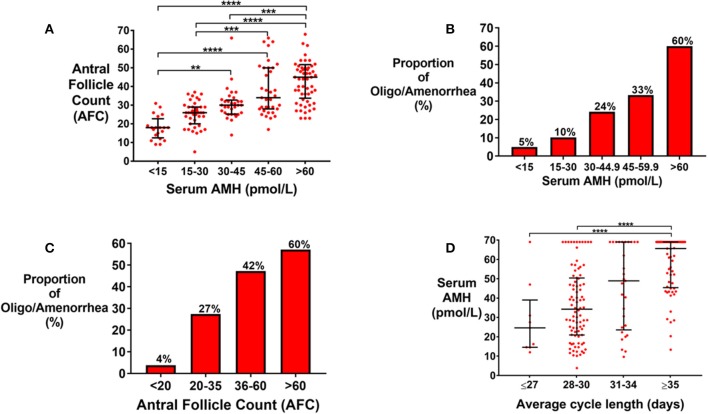
(A) Scattergram (median ± IQR) of serum anti-Mullerian hormone, AMH (pmol/L), by total antral follicle count (AFC) across both ovaries. Groups were compared by Kruskal Wallis test with post-hoc Dunn's multiple comparison test. AFC was significantly higher by category of serum AMH. **P < 0.01, ***P < 0.001, ****P < 0.0001. (B) Frequency of oligomenorrhea was increased by category of serum AMH (pmol/L) when compared by univariate logistic regression (P < 0.0001). The sample size in each AMH category is as follows: <15 pmol/L (n = 20); 15–30 pmol/L (n = 39), 30–44.9 pmol/L (n = 33), 45–59.9 (n = 33), >60 pmol/L (n = 60). The odds of oligomenorrhea was increased 2.2-fold (95% CI 0.2–20.8) in those with AMH 15–30 pmol/L; 6.1-fold (95% CI 0.70–52.9) in those with AMH 30–44.9 pmol/L; 9.5-fold (95% CI 1.1–80.5) in those with AMH 45–59.9 pmol/L; and 28.5-fold (95% CI 3.6–227.3) in those with AMH >60 pmol/L, compared to those with AMH < 15 pmol/L. (C) Frequency of oligomenorrhea was increased by categories of AFC when compared by univariate logistic regression (P < 0.0001). The number of patients in each category is as follows: AFC < 20 (n = 26); 20–35 (n = 91); 36–60 (n = 55), >60 (n = 15). The odds of oligomenorrhea was increased 9.5-fold (95% CI 1.2–73.6) in those with AFC 20–35; 22.4-fold (95% CI 2.8–177.2) in those with AFC 36–60; and 37.5-fold (95% CI 3.6–332) in those with AFC >60 when compared to those with AFC < 20. (D) Scattergram (median ± IQR) of serum AMH (pmol/L) by average menstrual cycle lengths. Groups were compared by the Kruskal Wallis test with post-hoc Dunn's multiple comparisons test. Women with average menstrual cycle length of ≥35 days have higher AMH levels compared to those with menstrual cycle length of ≤ 27 days (P < 0.0001) or those with menstrual cycle length of 28–30 days. ****P < 0.0001.